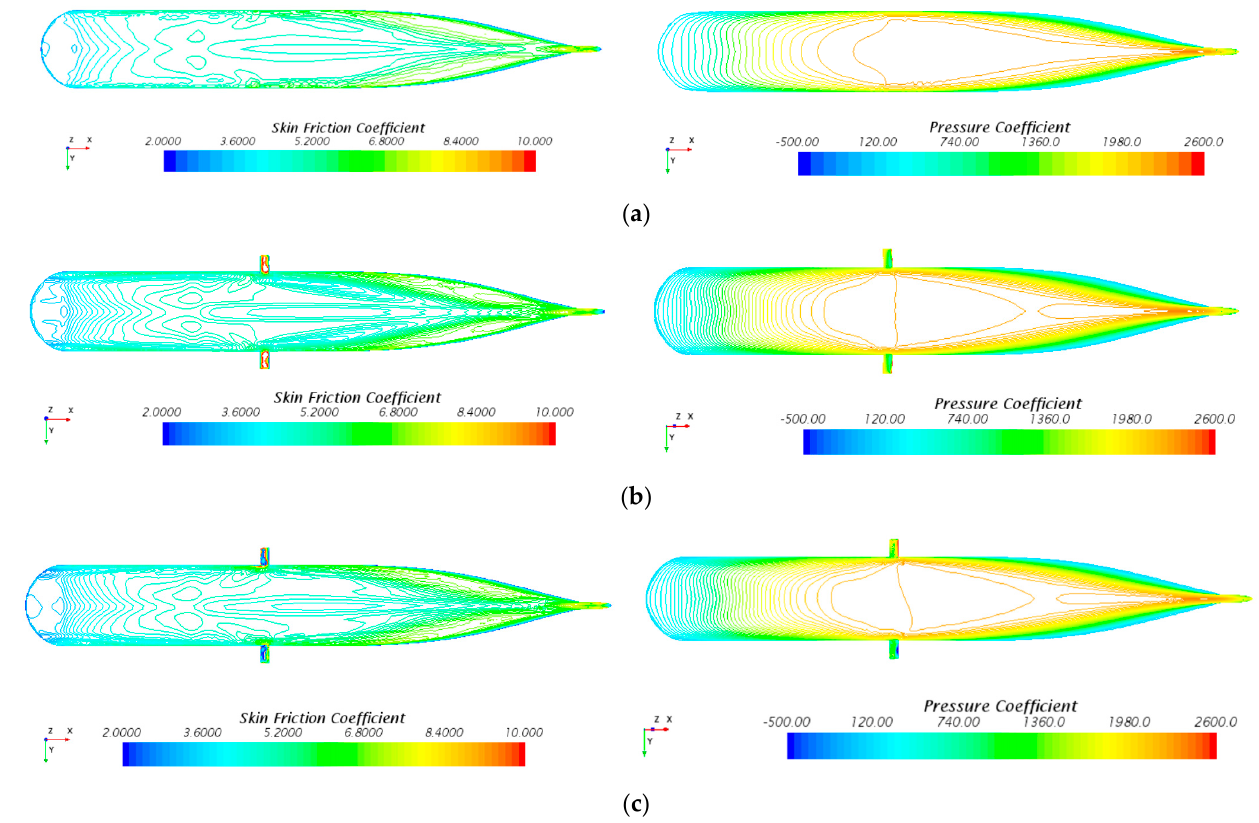
Figure 11. Pressure and skin friction coefficient distributions along the bottom at 18 kn. ( a ) Without fins. ( b ) With fins at 0° angle. ( c ) With fins at 20° angle.